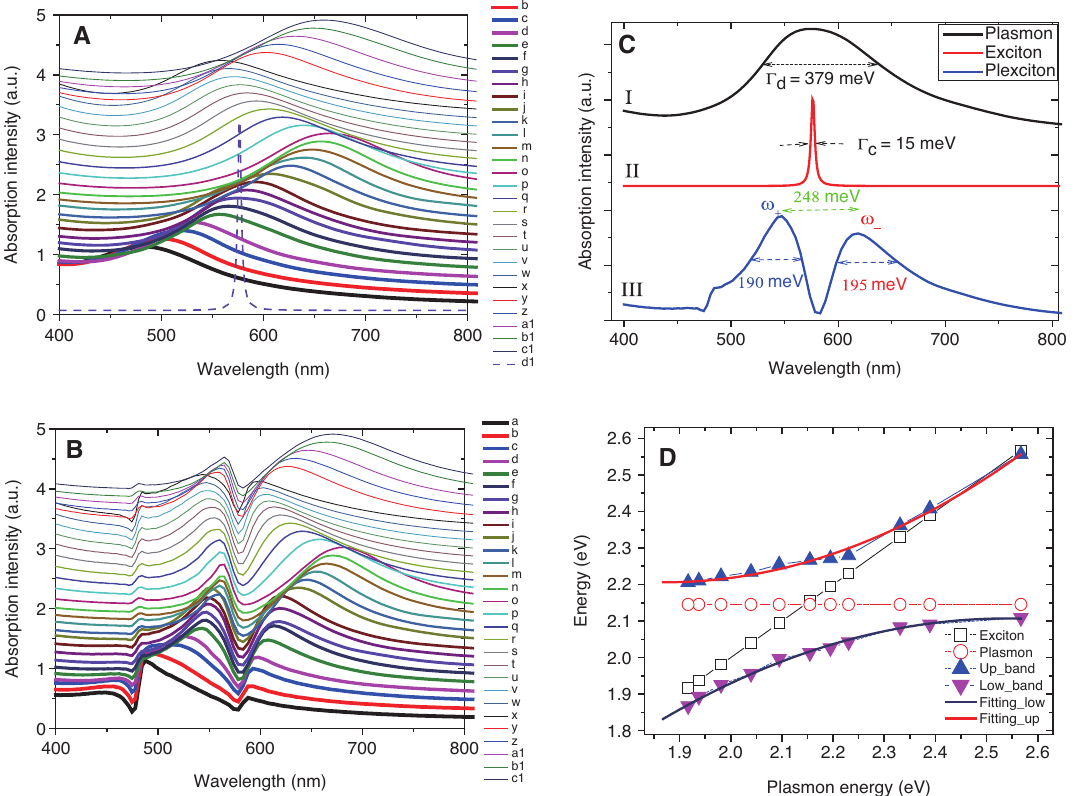
Figure 3: Simulation extinction spectra of HNSs with different thicknesses of the Au shell and exciton-HNS systems. (A) Simulation extinction spectra of Ag@Au hollow nanoshell with various plasmon resonances obtained by FDTD method. The dashed curve e1 is the absorption spectrum of the exciton, with a Lorentzian lineshape. (B)Typical simulation extinction spectra of HNSs doped with J-aggregate with different thicknesses of the Au shell corresponding to (A). Extinction spectra of the HNS with LSPR at 575 nm strongly coupled to J-aggregates. (B) With various plasmon resonances obtained by FDTD method. The dashed curve e1 is the absorption spectrum of the exciton, with a Lorentzian lineshape. (C) Simulation extinction spectra of (I) the bare HNS with surface plasmon resonance at 576 nm, (II) the Lorenze exciton model with the band at 575 nm, and (III) HNS/exciton ensembles. (D) Simulation dispersion curves of the hybrid state energies plotted as a function of their corresponding plasmon resonance. Anticrossing analysis of the plexciton with upper branch ω + (the solid blue triangular symbol) and lower branch ω (the solid pink triangular symbol); the circle and the square patterns illustrate the − uncoupled exciton and plasmon, respectively. Here the Rabi splitting of the first SC is 248 meV, and that of the second SC is 210